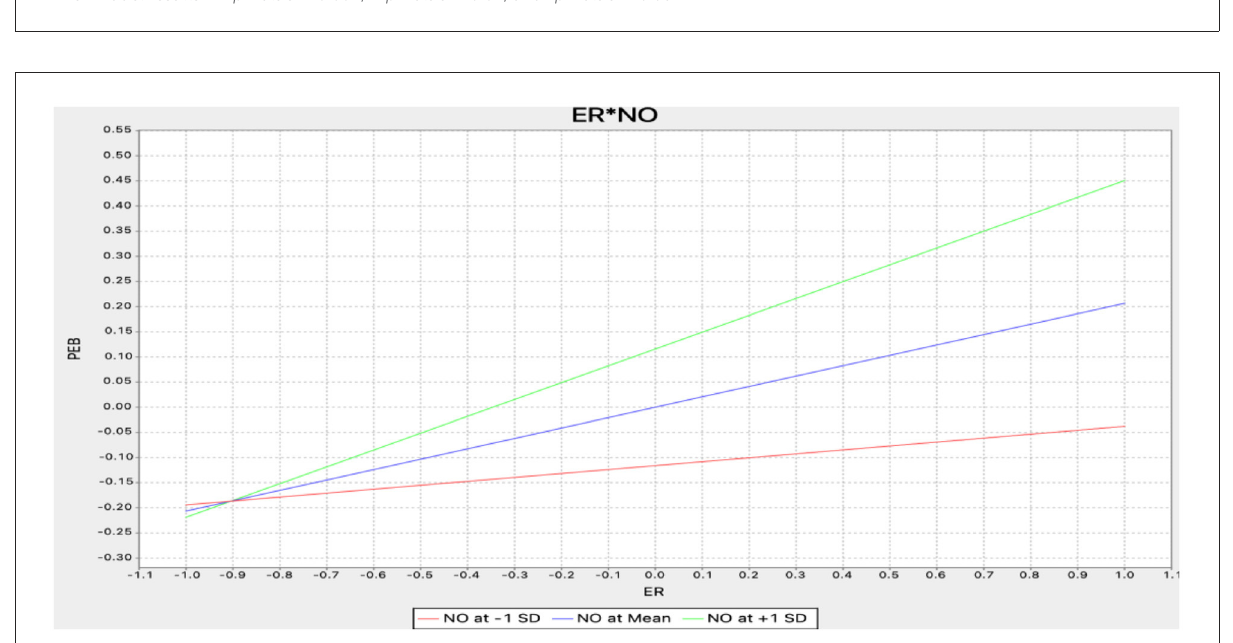
FIGURE3 Moderating effect (ER*NO-PEB). ER, environmental responsibility; PEB, pro-environmental behavior; NO, nostalgia.